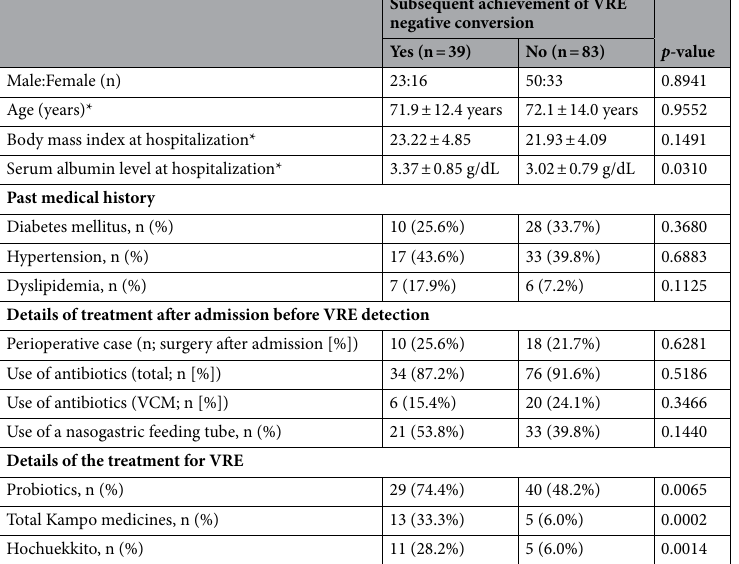
Table 2. Comparative analysis of clinical and therapeutic parameters according to the subsequent achievement of VRE negative conversion. Kampo medicines (total) means hochuekkito (n = 16), juzentaihoto (n = 1), and ninjin’yoeito (n = 1). VCM vancomycin, VRE vancomycin-resistant enterococcus. *Mean and standard deviation.